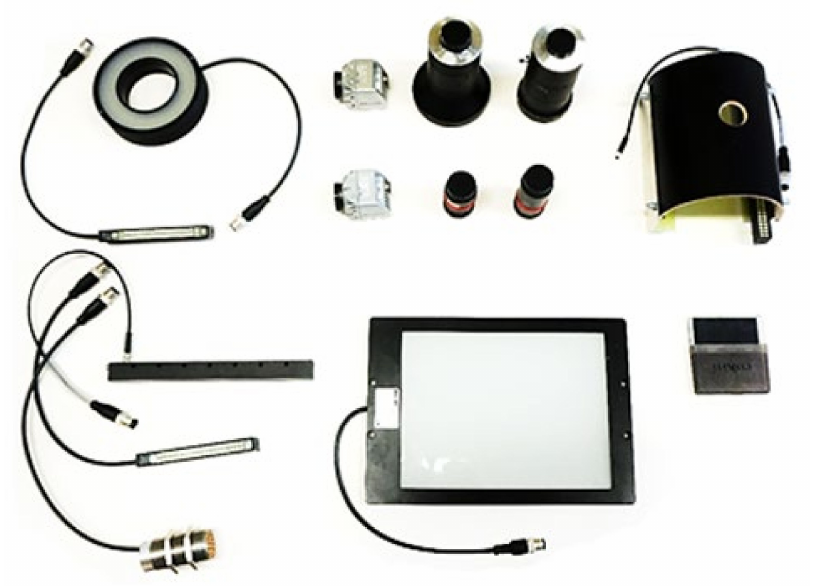
Figure 3. Equipment used for image